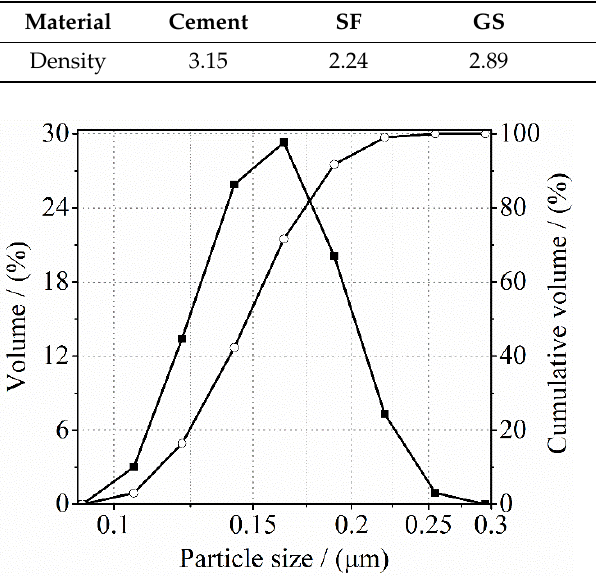
Table 2. Density of cement and mineral admixtures (g/cm 3 ).